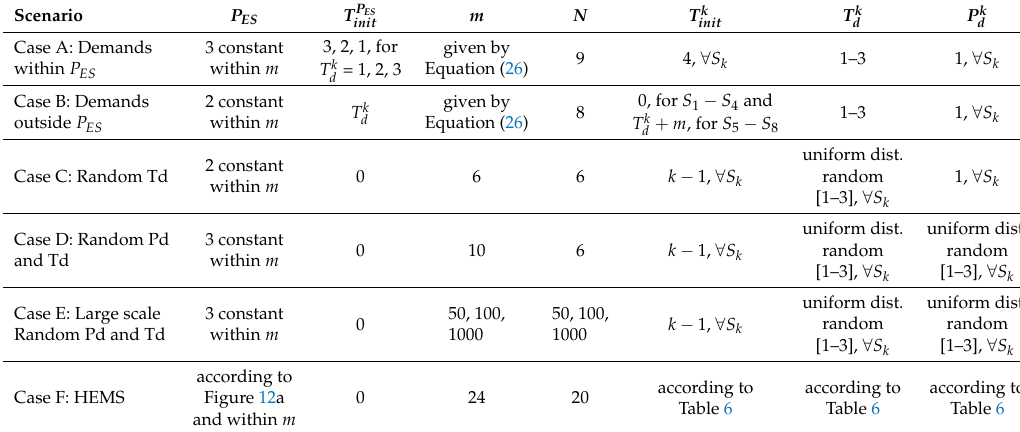
Table 5. Summary of simulation